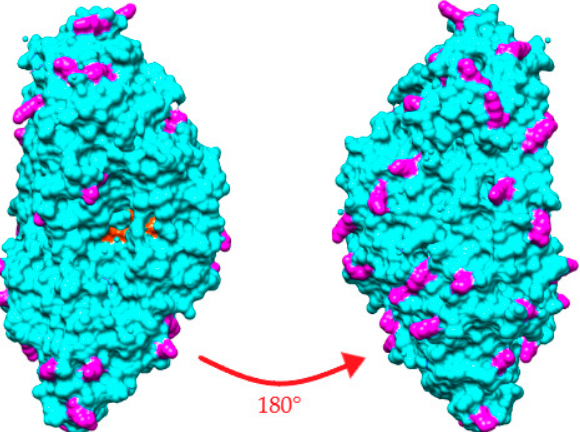
Figure 1. Tridimensional visualization of Aspergillus oryzae β -galactosidase structure. The active site is marked in orange, and the lysine residues are marked magenta. This model was obtained from Protein Data Bank, under the access code 4IUG (https://www.rcsb.org/structure/4i.ug, accessed on 1 December 2022) [4], and modified on the software Chimera